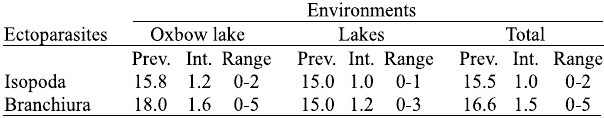
Table 1 . Prevalence (Prev. - %) and mean intensity (Int.)